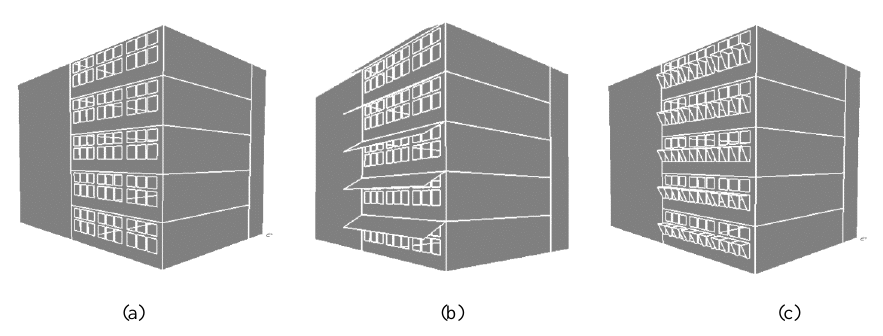
Fig. 2. Fenestration models: (a) without shading; (b) with overhang; (c) with light